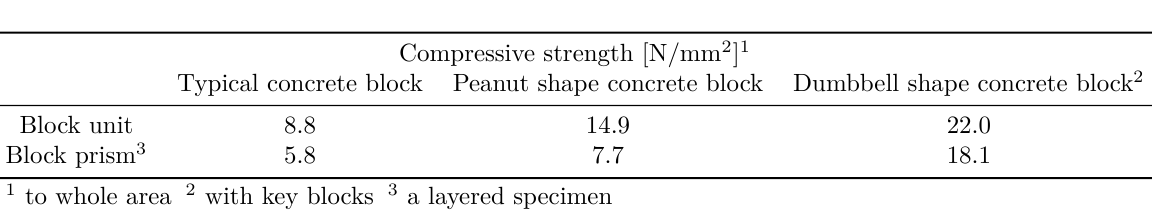
Table 1. Mechanical properties of each concrete